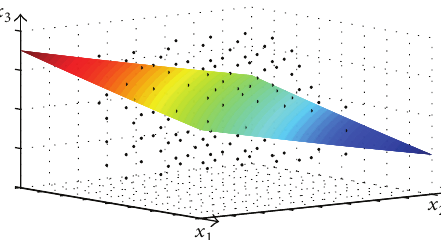
Figure 8: The optimal classification hyperplane for identifying two states using soft margin